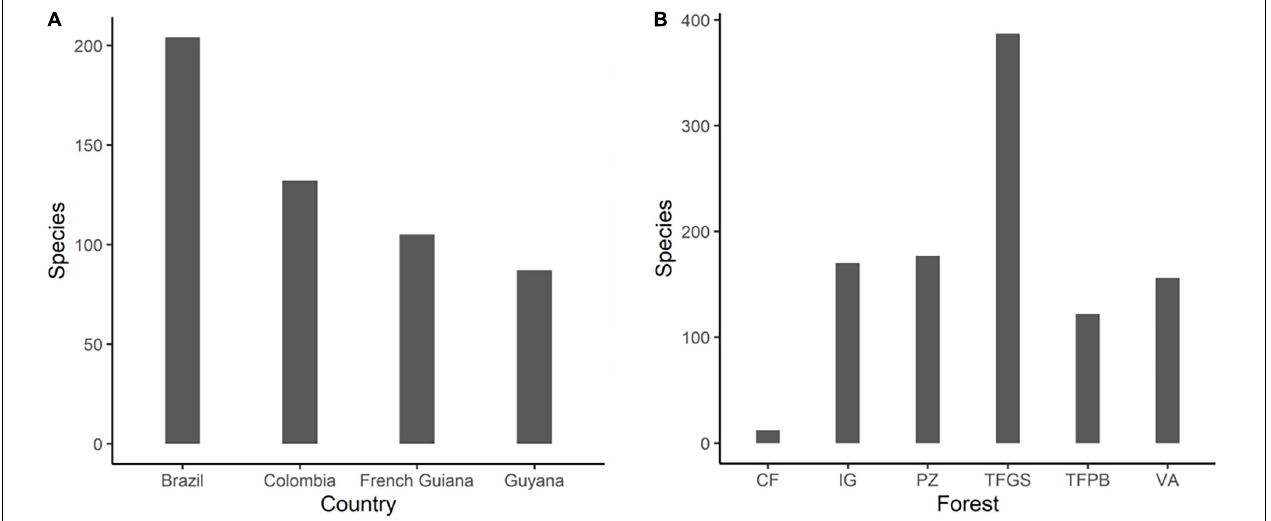
FIGURE 3 | Species richness by country (A) and by environment (B) in Amazonia. There are clear differences in the number of species by environment and by country, however, this may be a reflection of the sampling effort for each location VA, Várzea; IG, Igapó; TFGS, Terra Firme Guiana Shield and TFPB, Terra Firme from the Pebas region; PZ, White Sand Forests on Podzols and CF, Coastal Sand Forests.